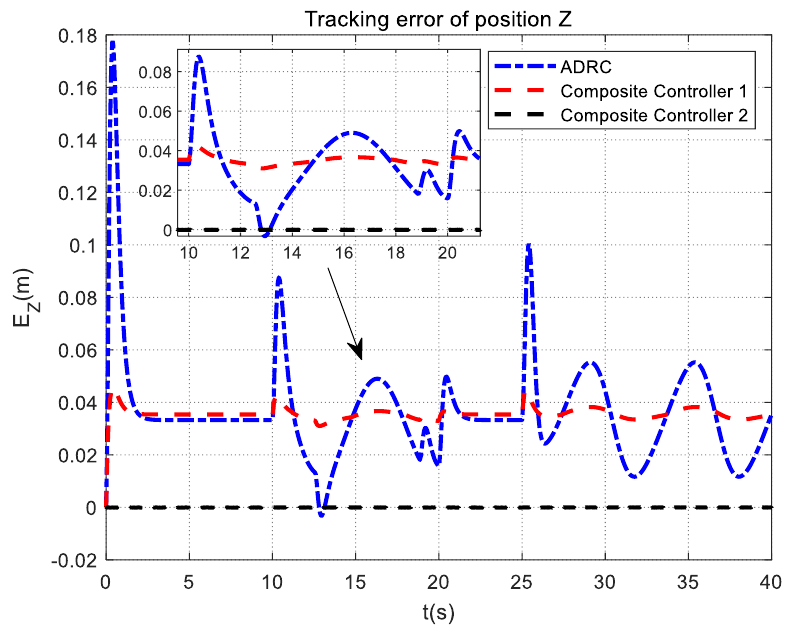
Figure 23. Tracking error of position Z control for QUAV under actuator time‑varying fault and disturbance condition.